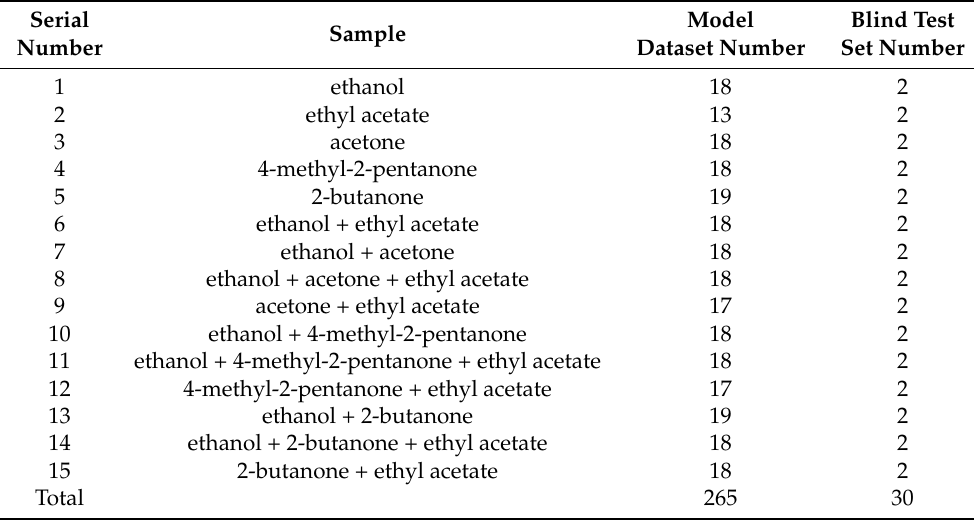
Table 1. Characterization of the experimental